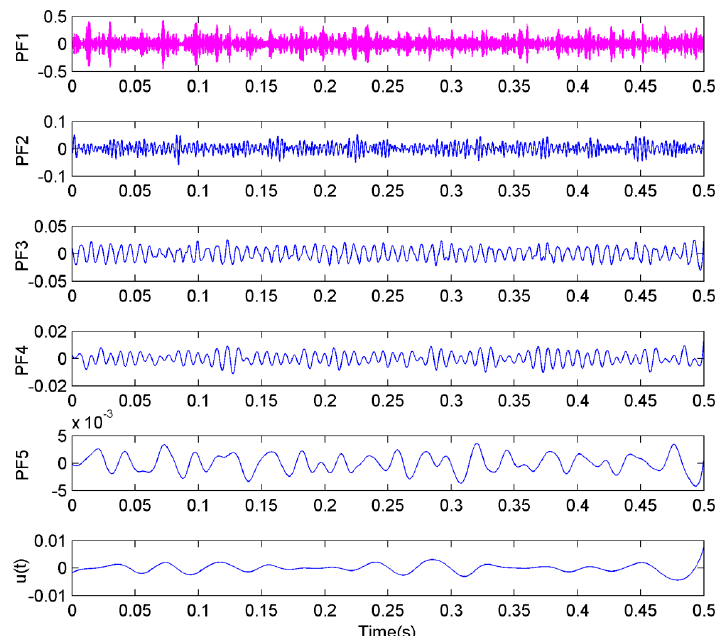
Figure 5. The LMD decomposition results of vibration signal of shearer cutting coal seam with f = 2.